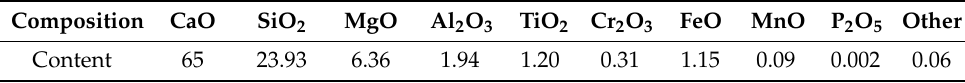
Table 1. Chemical composition of AOD slag/wt.